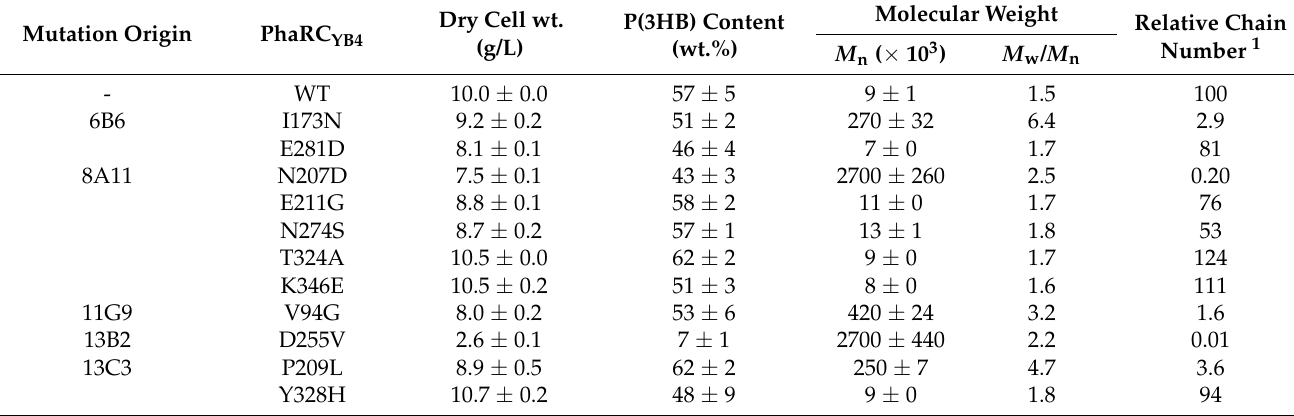
Table 3. PHA production of E. coli DH5 α expressing PhaRC YB4 with site-directed point mutation. Mutation